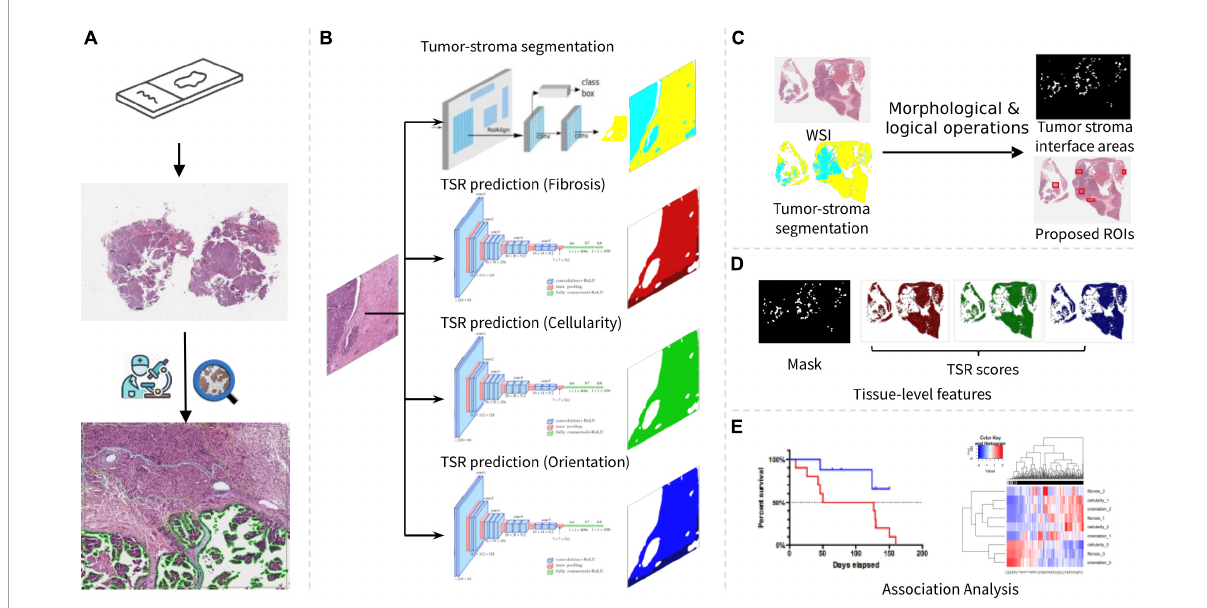
FIGURE1 Overview of our research workflow. (A) Slide scanning and annotation. (B) Tumor-stroma segmentation and TSR score estimation. (C) Tumor stroma interface area identification. (D) Tissue-level feature summarization. (E) Association